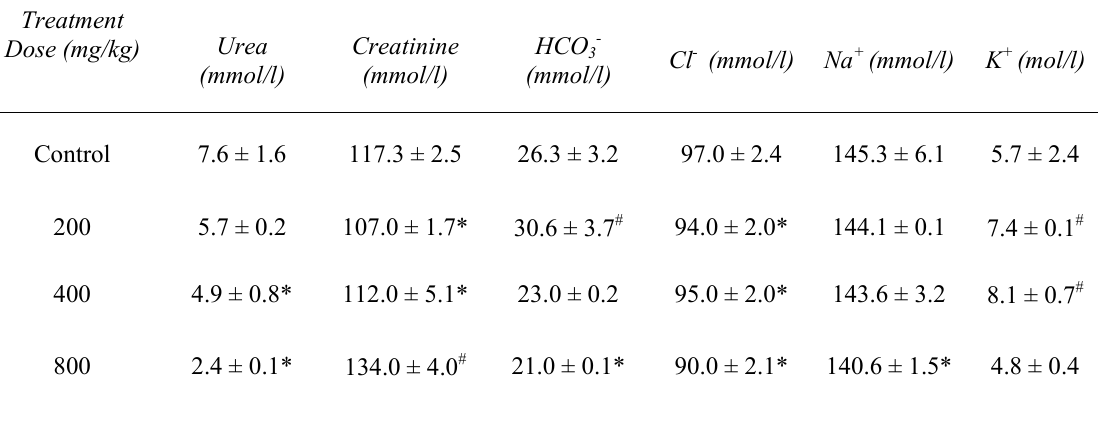
Table 2. Effect of Bonny light crude oil on serum electrolytes, urea and creatinine after 7 days of sub-chronic exposure to male